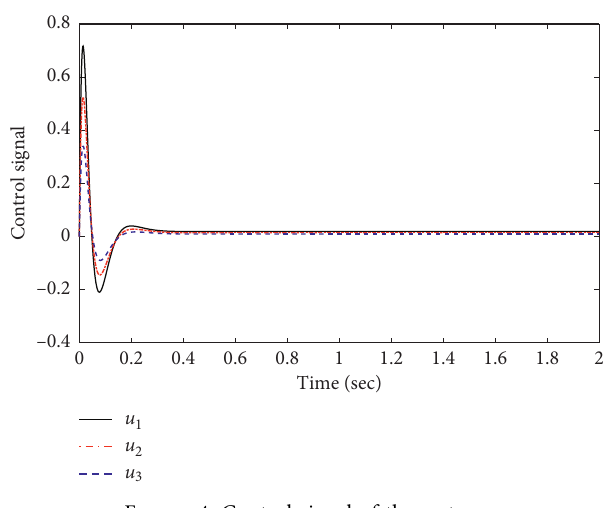
Figure 4: Control signal of the system. Table 2: Comparison between the proposed AISOSMC method with the previous method in [22]. Previous load frequency controller in Kinds of controller The AISOSMC approach Parameters